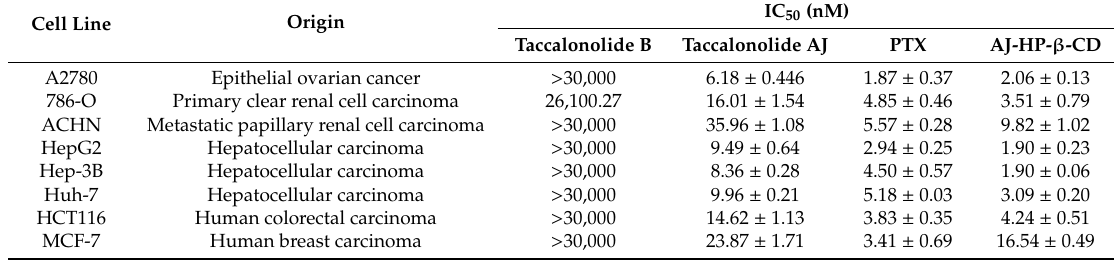
Table 1. Anti-proliferative profiles of TB, AJ, paclitaxel (PTX), and AJ-HP- β -CD in various human cancer cell